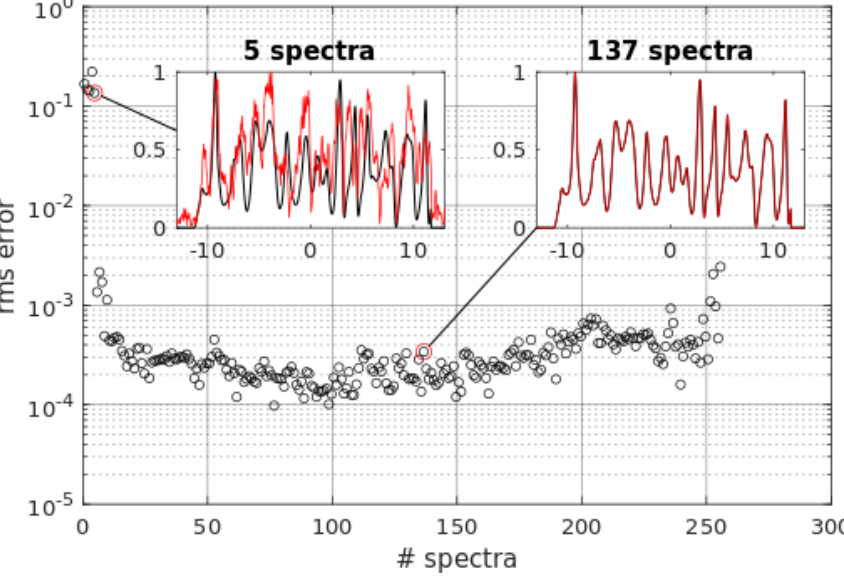
Figure 6. Ptychographic reconstruction of a simulated SASE waveform as a function of the number of electron spectrometers. The insets show the original (black curve) and the reconstructed (red curve) X-ray waveforms as functions of time for five and for 137